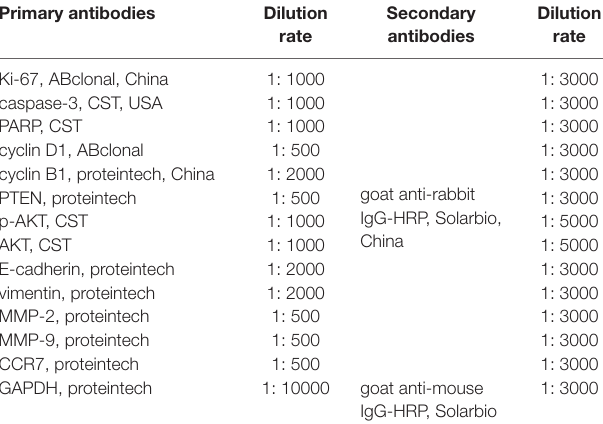
TABLE 1 | Antibody